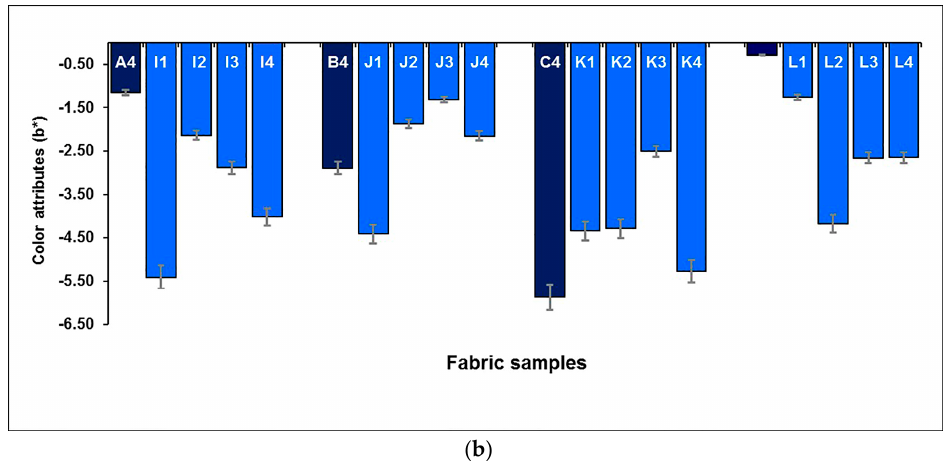
Figure 15. Effect of mixing black yarn on the color attributes of blue-red mixed fabrics: ( a ) redness- greenness (a*); ( b ) blueness-yellowness (b*).